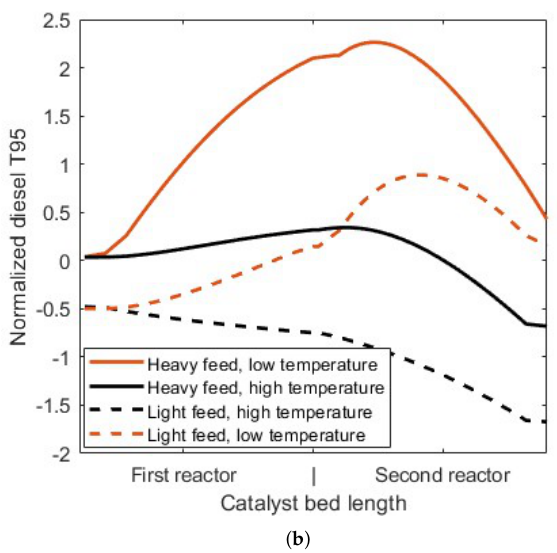
Figure 7. Difference between overall T95 and diesel T95 behavior through the reactors. ( a ) Decreasing overall T95 through the catalyst bed depending on the operating temperature. ( b ) T95 trajectory of the diesel fraction through the reactors.